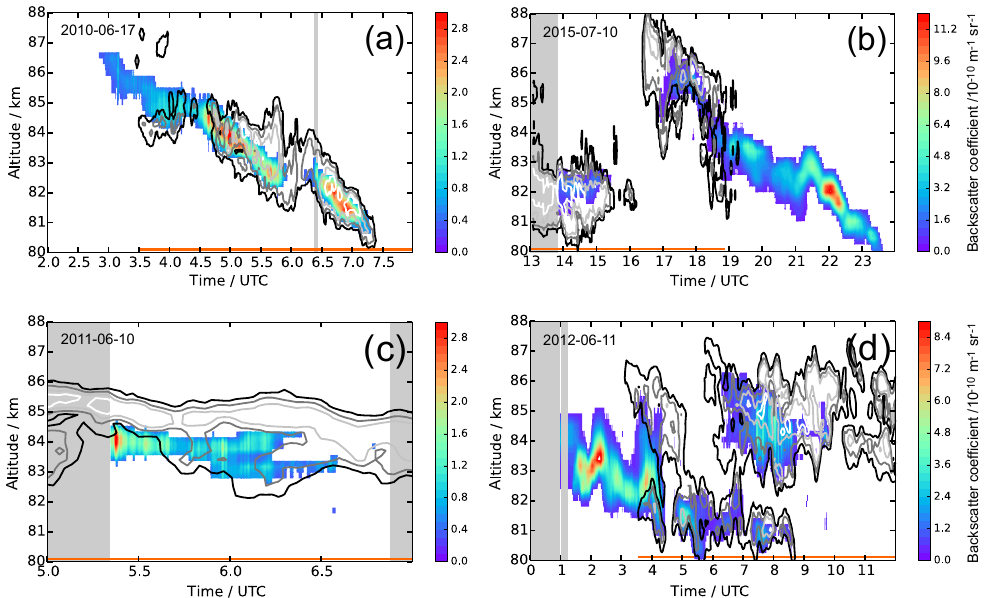
Figure 2. Examples of observations of MSEs (contour lines at − 12/ − 6/0/6dB, if applicable) and NLCs (filled contours with scale on the right). The orange lines indicate periods with solar elevation > 5 ◦ . The gray shaded areas mark periods without lidar soundings due to the presence of clouds. (a) 17 June 2010: the MSE starts after sunrise into existing NLCs. (b) 10 July 2015: the MSE vanishes after sunset while the NLC continues. (c) 10 June 2011: when the lidar operation begins, the NLC is immediately detected, but does not extend as high as the MSE. (d) 11 June 2012: the MSE starts after sunrise when the NLC already existed and continues especially at higher altitudes when the NLC